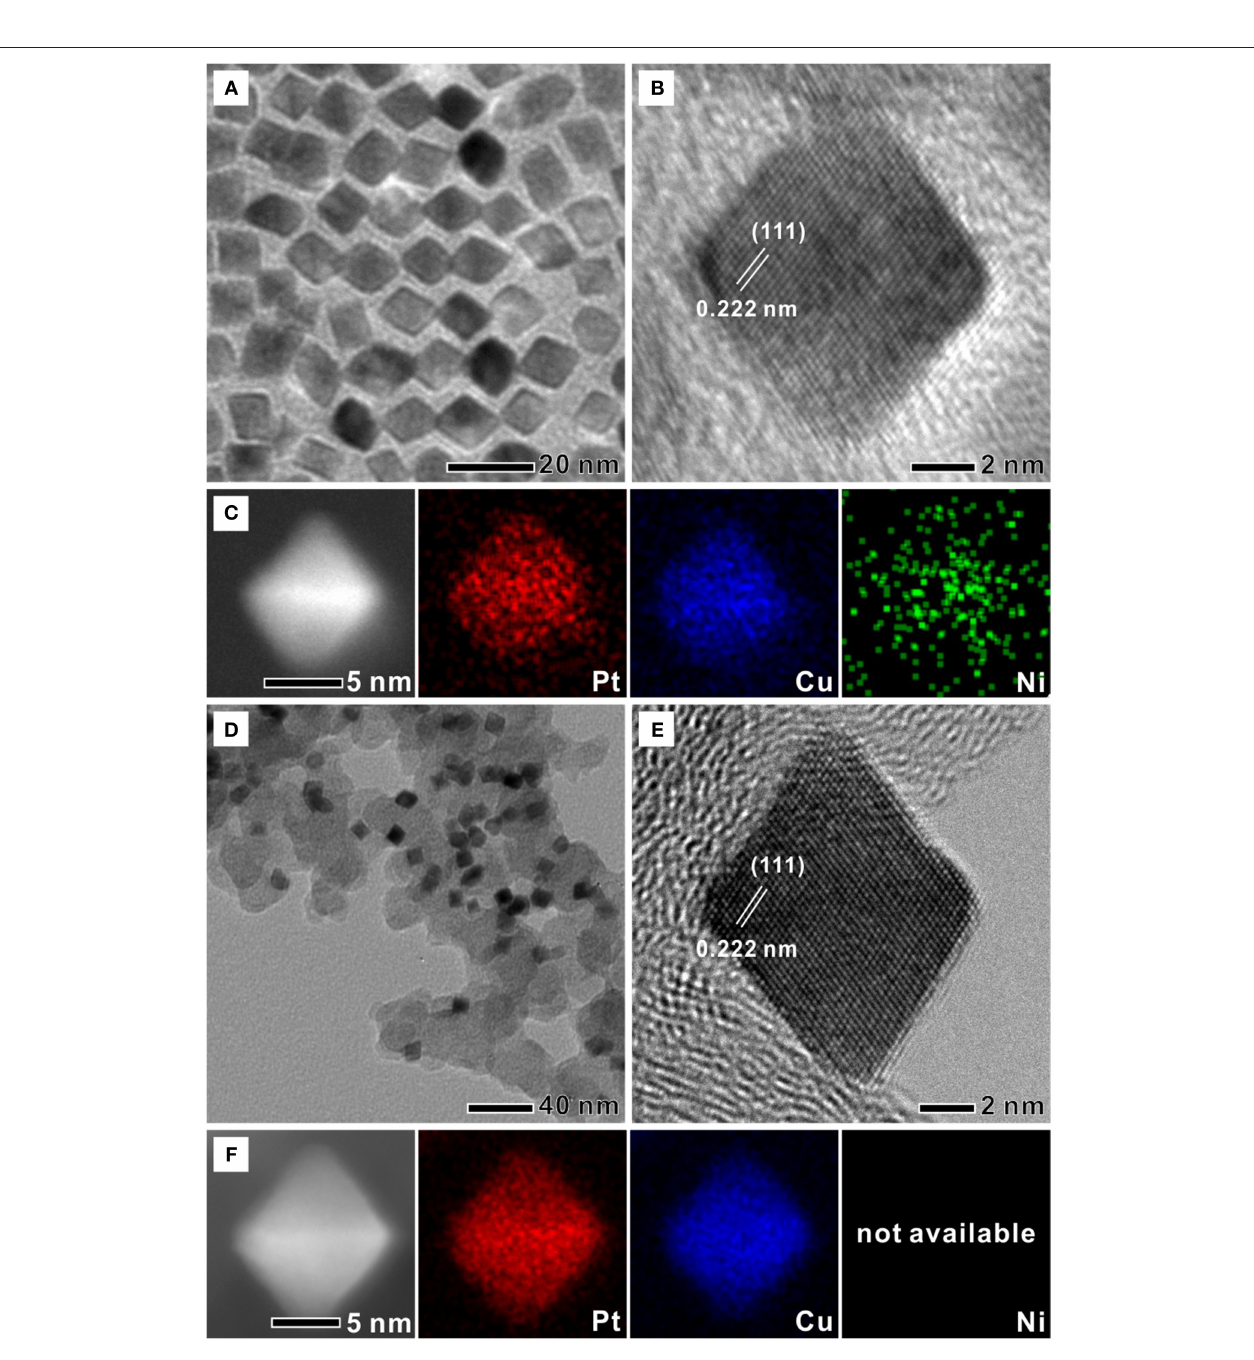
FIGURE 1 | TEM and high-resolution TEM images of (A,B) Ni(OH) 2 decorated Pt-Cu octahedra (Ni(OH) 2 -PtCu) and (D,E) Ni(OH) 2 decorated Pt-Cu octahedra/C treated with acetic acid (PtCu/C-HOAc). STEM with corresponding EDS mapping images of (C) Ni(OH) 2 -PtCu and (F) PtCu/C-HOAc.